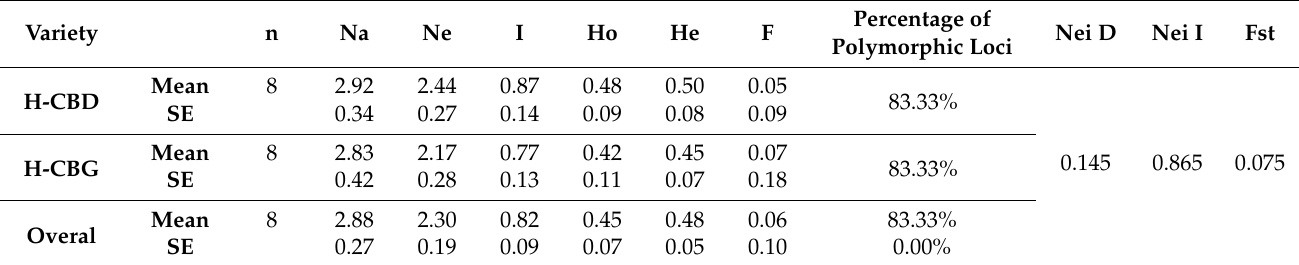
Figure 3. Allele frequencies for the two Cannabis varieties: the H-CBD and the H-CBG. Table 2. Genetic informative parameters of Cannabis sativa L.